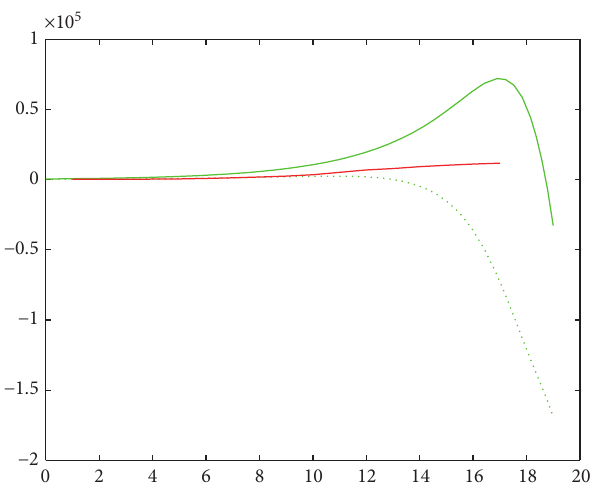
Figure 5: Plots of potential curve of telephone in urban area and rural area governed by model (68) (the control error rate is 45%).